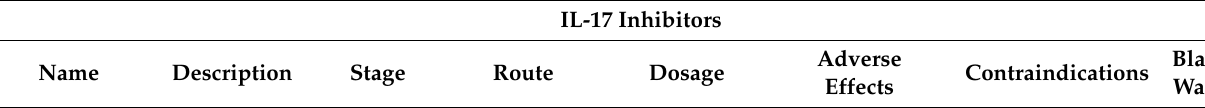
Table 4. Summary of IL-17 Inhibitors. IL-17